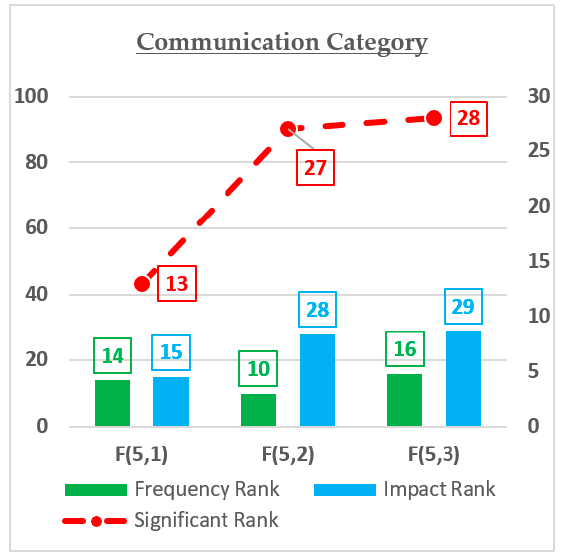
Figure 11. Significant risks in the communication category.